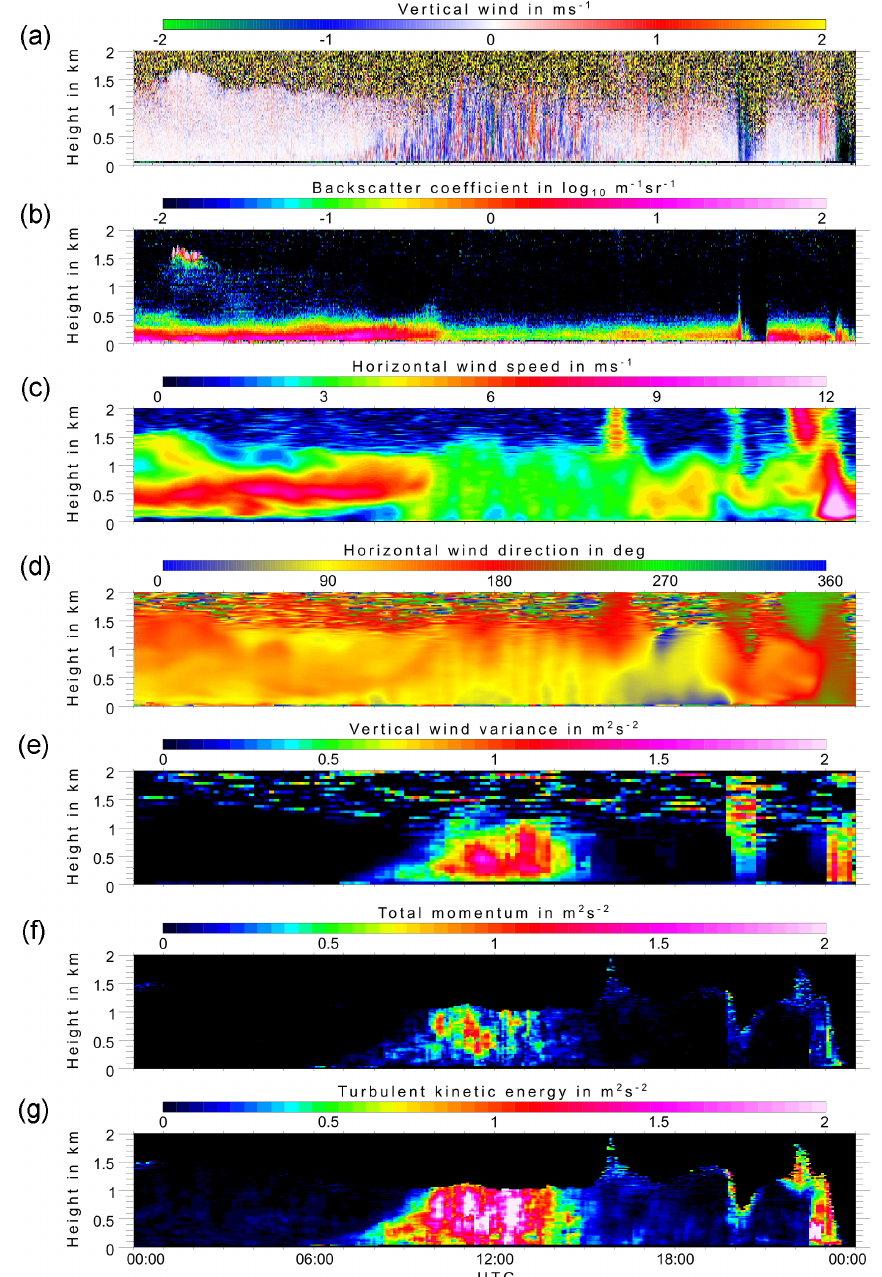
Figure 4. Measurements of the vertical and horizontal wind from 27 June 2021. In addition to the wind itself, the backscatter coefficient, vertical wind variance, TKE and momentum flux are also